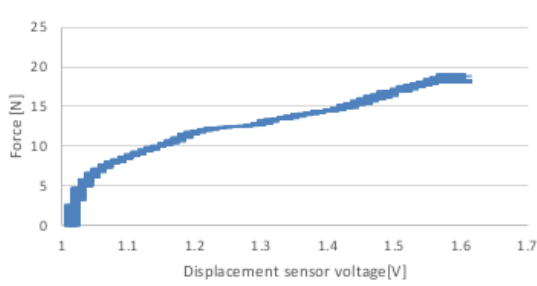
Figure 9: Characteristics of the displacement sensor.